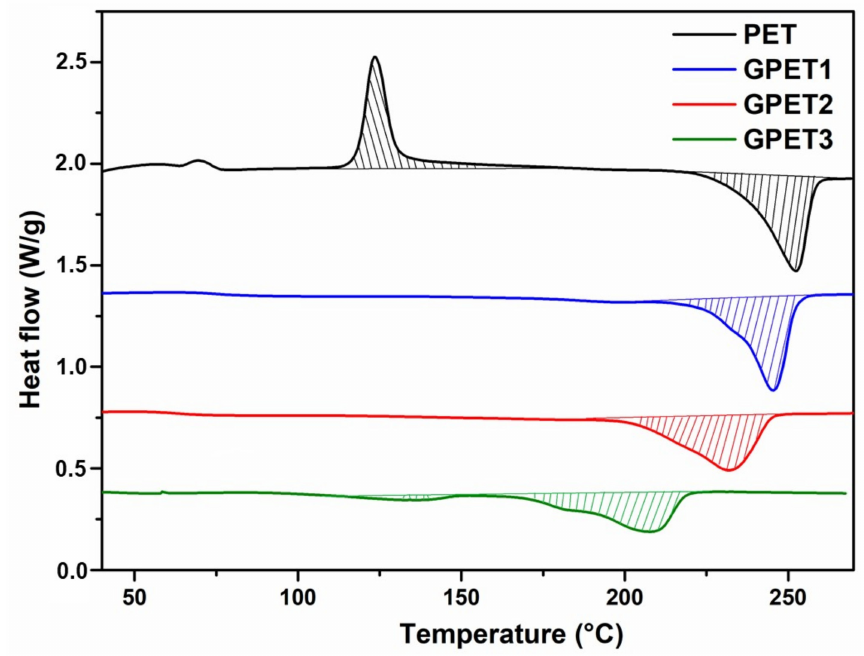
Figure 5. DSC first heating scans of extruded PET and glycolysed PET oligomers.